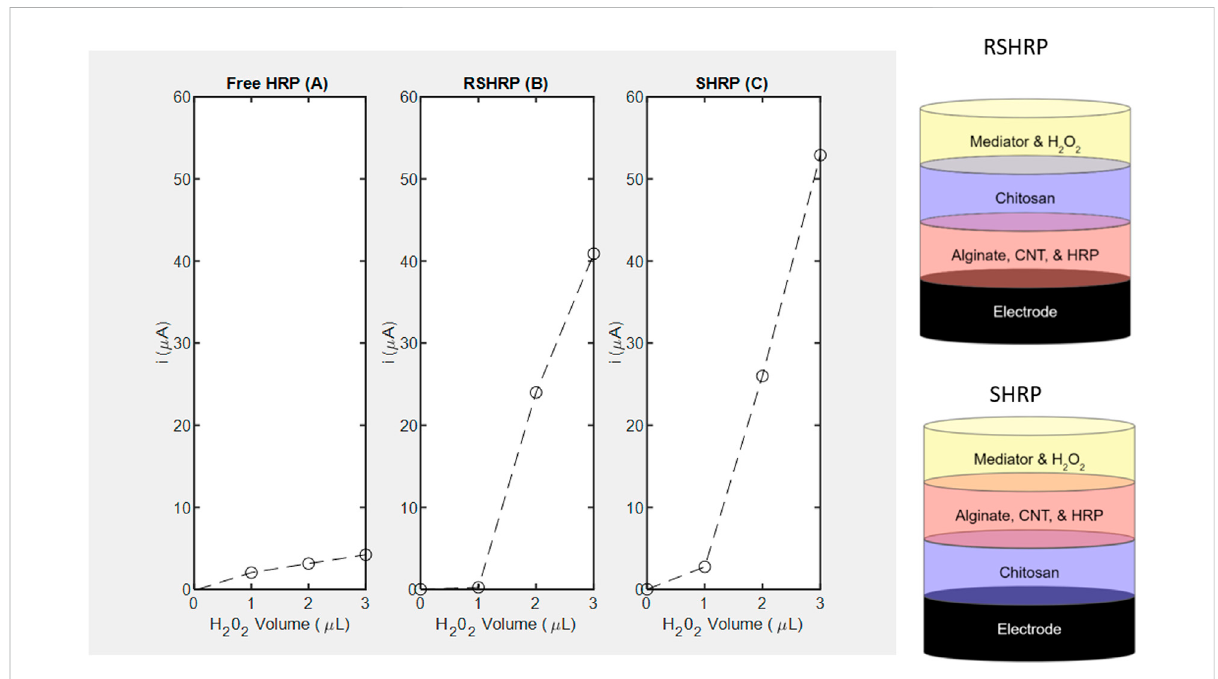
FIGURE 5 Amperometric studies of horseradish peroxidase measured at − 0.1 V using H 2 O 2 as substrate and corresponding layer stacking con fi gurations (not drawn to scale). (A) Free enzyme; (B) RSHRP nanocomposite fi lm where chitosan is not in contact with the SPCE; (C) SHRP nanocomposite fi lm where chitosan is in contact with the SPCE.